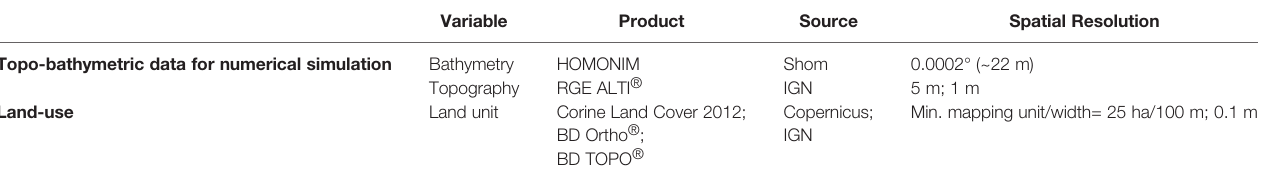
TABLE 3 | Summary of topo-bathymetric and land-use datasets used in the